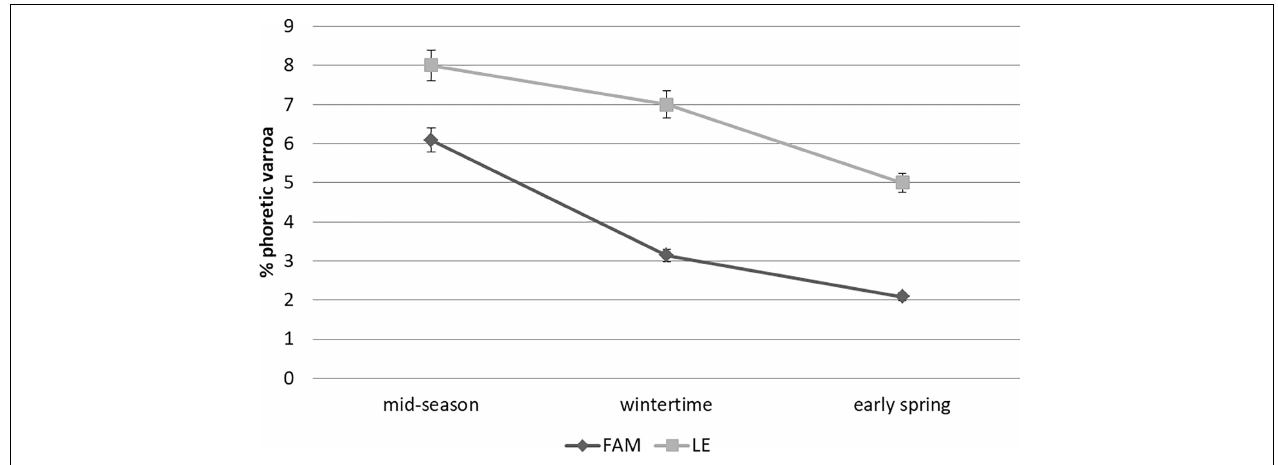
FIGURE 5 | Mean percentage of phoretic Varroa ( ± SE) of A. mellifera colonies from Leales (LE) and Famaillá (FAM) apiaries through the beekeeping season 2017–2018 (mid-season, wintertime and early